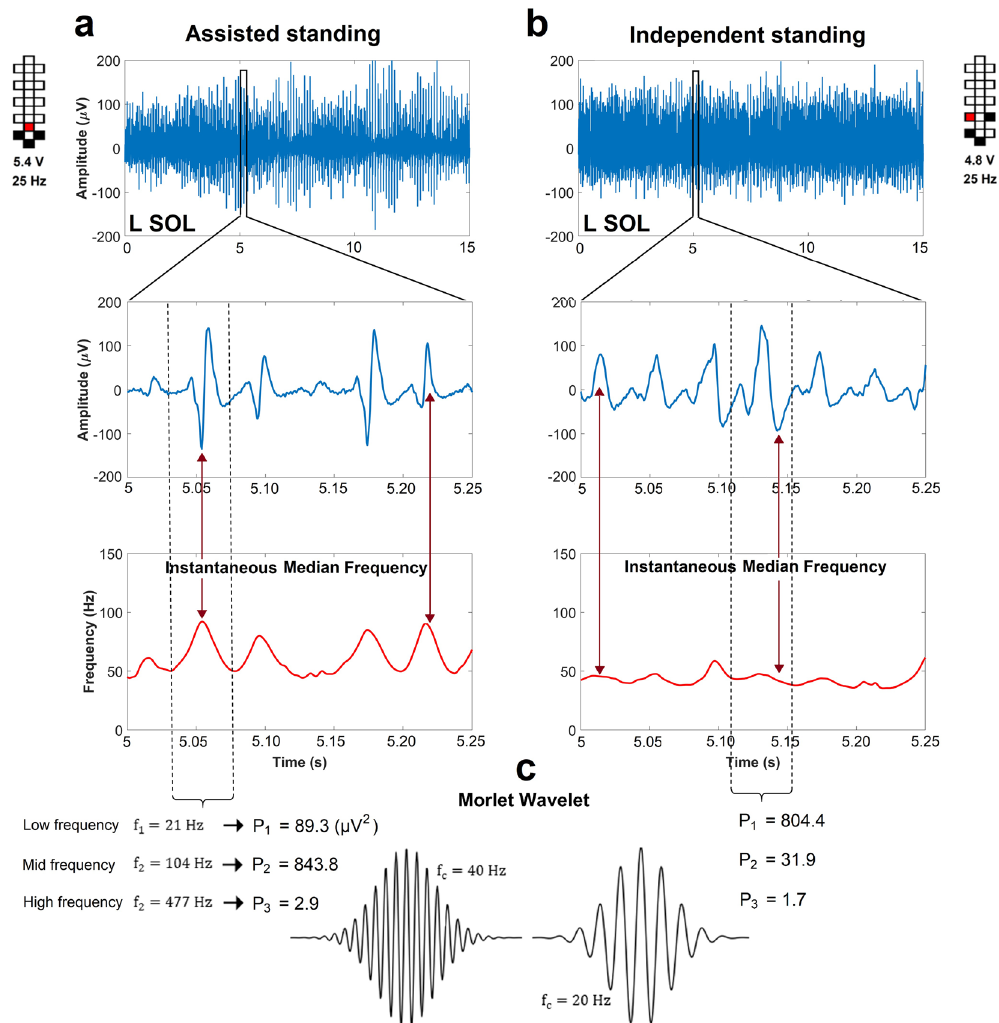
Figure 7. Representative spinal cord evoked responses collected during assisted and independent standing. EMG activity collected from the left soleus (L SOL) muscle of research participant A45 ( a) during standing with external assistance for hips and knees extension and ( b) during standing with independent lower limb extension. Spinal cord evoked responses and instantaneous median frequency calculated by continuous wavelet transform are reported for EMG activity included in the windows entered in the top panels. ( c) Exemplary Morlet wavelet signals with high (40 Hz, left) and low (20 Hz, right) central frequency (f c ). The signal power (P, µ V 2 ) at low (21 Hz), mid (104 Hz) and high (477 Hz) frequency bins is calculated for the spinal cord evoked responses highlighted by the dashed lines. Signal power collected during assisted standing is more concentrated at the mid frequency bin, while signal power collected during independent standing is more concentrated at the low frequency bin. Stimulation amplitude, frequency and electrode configuration (cathodes in black, anodes in red, and inactive in white) are reported for the two standing